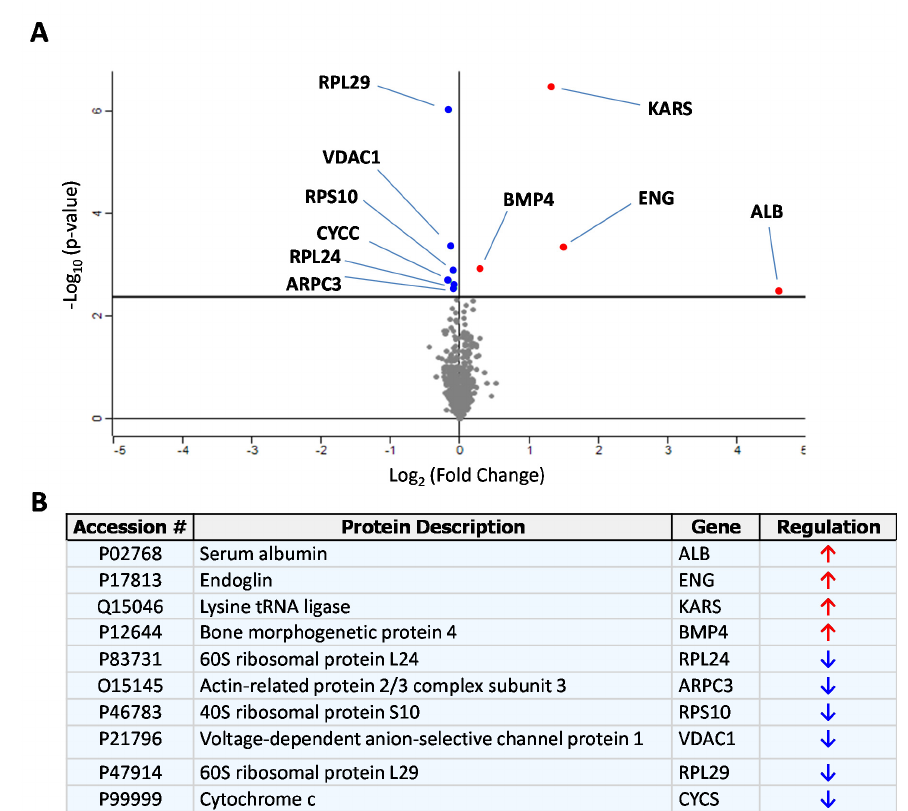
Figure 1. iTRAQ identification of di ff erentially secreted proteins by human umbilical vein endothelial cells (HUVECs) in the presence of sEng. ( A ) Volcano type graph where secreted proteins from sEng-treated HUVECs (HUVECs-sEng) that change significantly with respect to the untreated control (HUVECs-Control) are indicated. The horizontal axis represents fold changes in induction of the ratio HUVECs-sEng/HUVECs-Control, considering negligible differences those values closer to 0. The vertical axis represents the -Log10 (p-value), and the continuous horizontal line plotted at the value of 2.3, is equivalent to a p-value of 0.005. The central gray point cloud represents quantified but not statistically significant proteins. Inhibited or over-expressed proteins with statistically significant differences after treatment with sEng are represented in blue (upper left quadrant) or red (upper right quadrant), respectively. ( B ) Table showing the list of proteins represented in the graph in which statistically significant differences were found, including the corresponding access number in the UniProt database (http://www.uniprot.org/uniprot/).